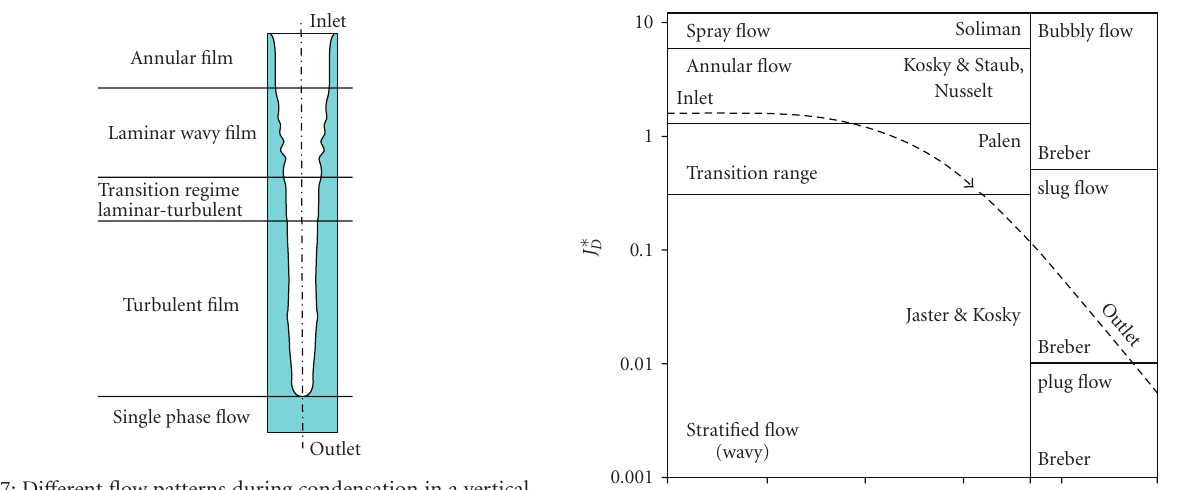
Figure 7: Di ff erent flow patterns during condensation in a vertical tube.